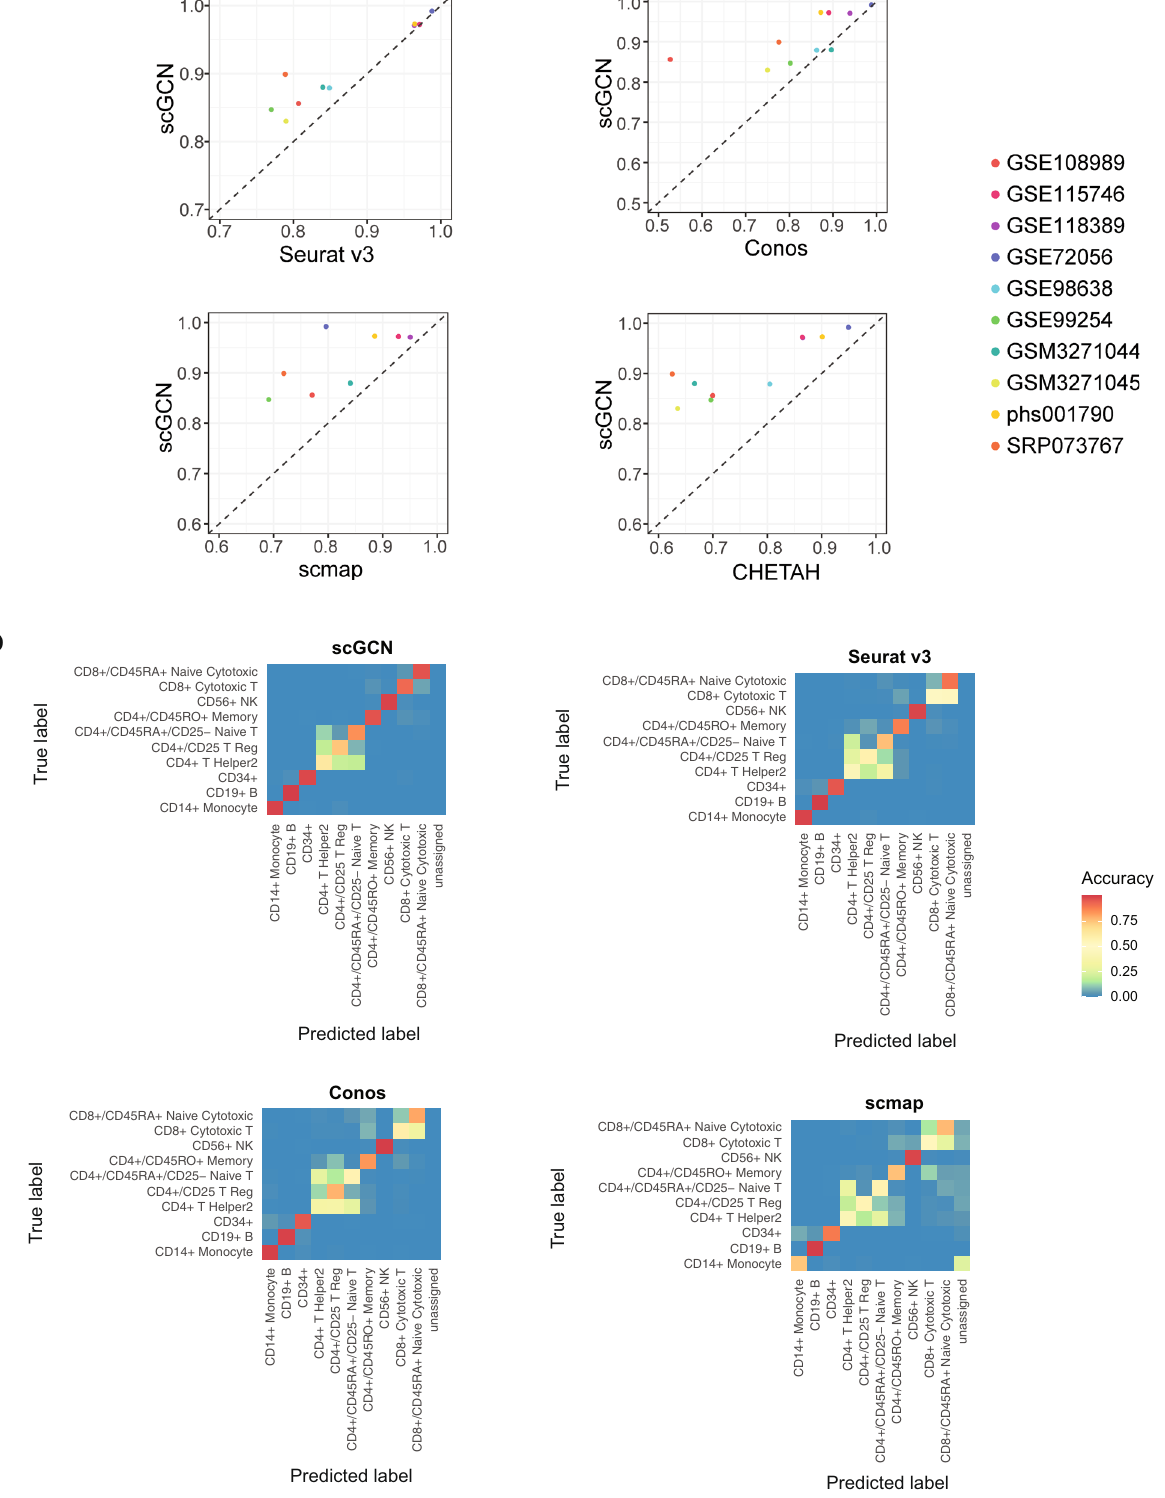
Fig. 2 Performance of label transfer within datasets. a Performance of scGCN and other methods (Seurat v3, Conos, scmap, and CHETAH) are measured by the accuracy score on ten datasets. Each point represents the accuracy scores of scGCN versus an alternative method on one dataset. The dashed line represents equivalent accuracy between two methods. Dots above the dashed line indicate that scGCN outperforms the corresponding method on these datasets. b Heatmap of the accuracy matrix of each cell type, including different T-cell subtypes, B-cells, and monocytes, which are identi fi ed by different methods based on the single cell dataset (SRP073767). Source data are provided as a Source Data fi